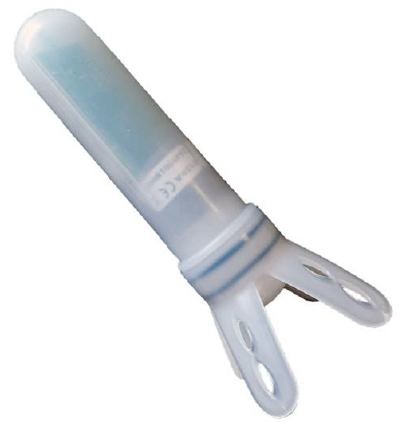
Figure 1. Representation of the intravaginal probe for the calving alarm system. The base works as an anchoring system while the cylindrical bin contains light and temperature sensors, together with a circuit board equipped with a transmitter. The probe is 174 mm in length, the cylindrical bin is 34 mm in diameter and the fin-shaped base is 78.5 mm in diameter. The rounded extremity con- tains a magnet for communication with the Central Unit.